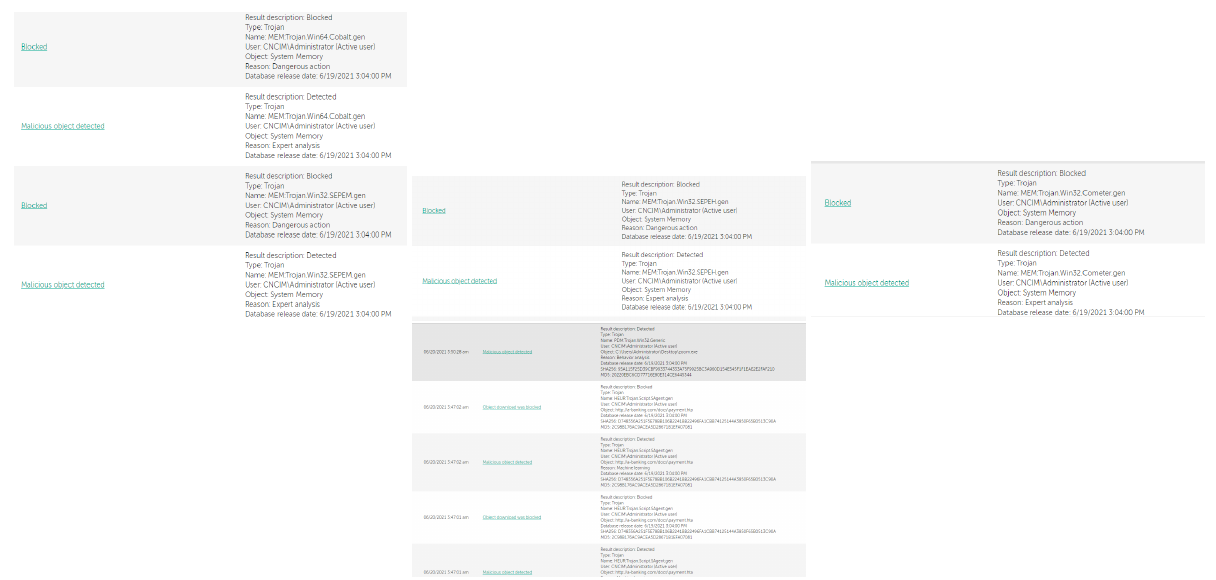
Figure 14. Screenshots from KEDR illustrating the malicious activity that it detected and